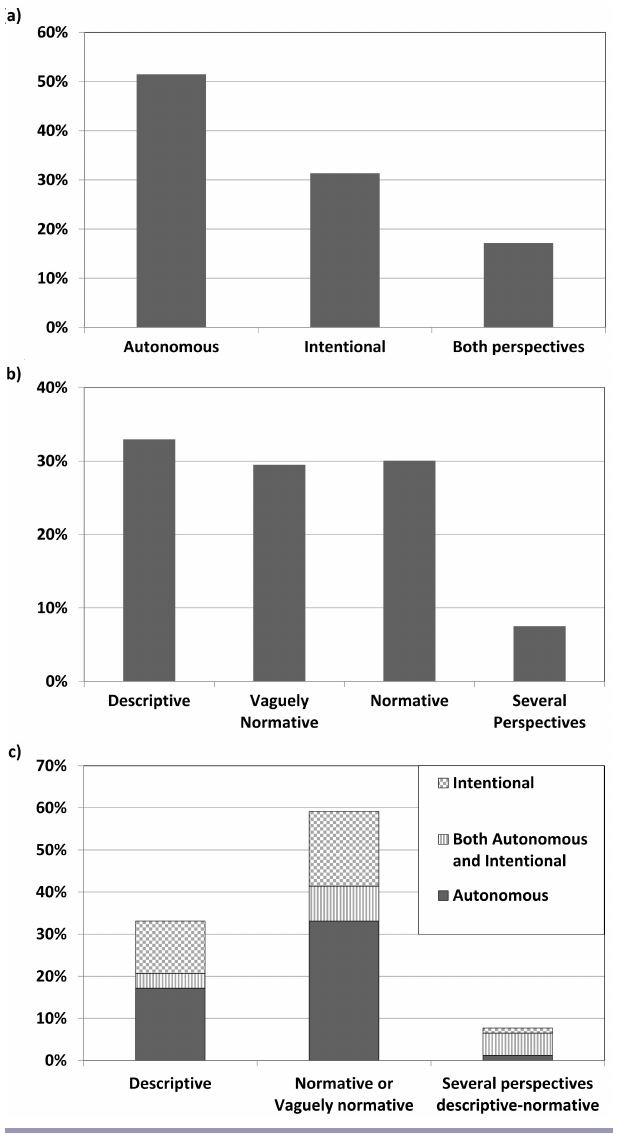
Fig. 2. (a) Autonomous vs. intentional. “Both” refers to